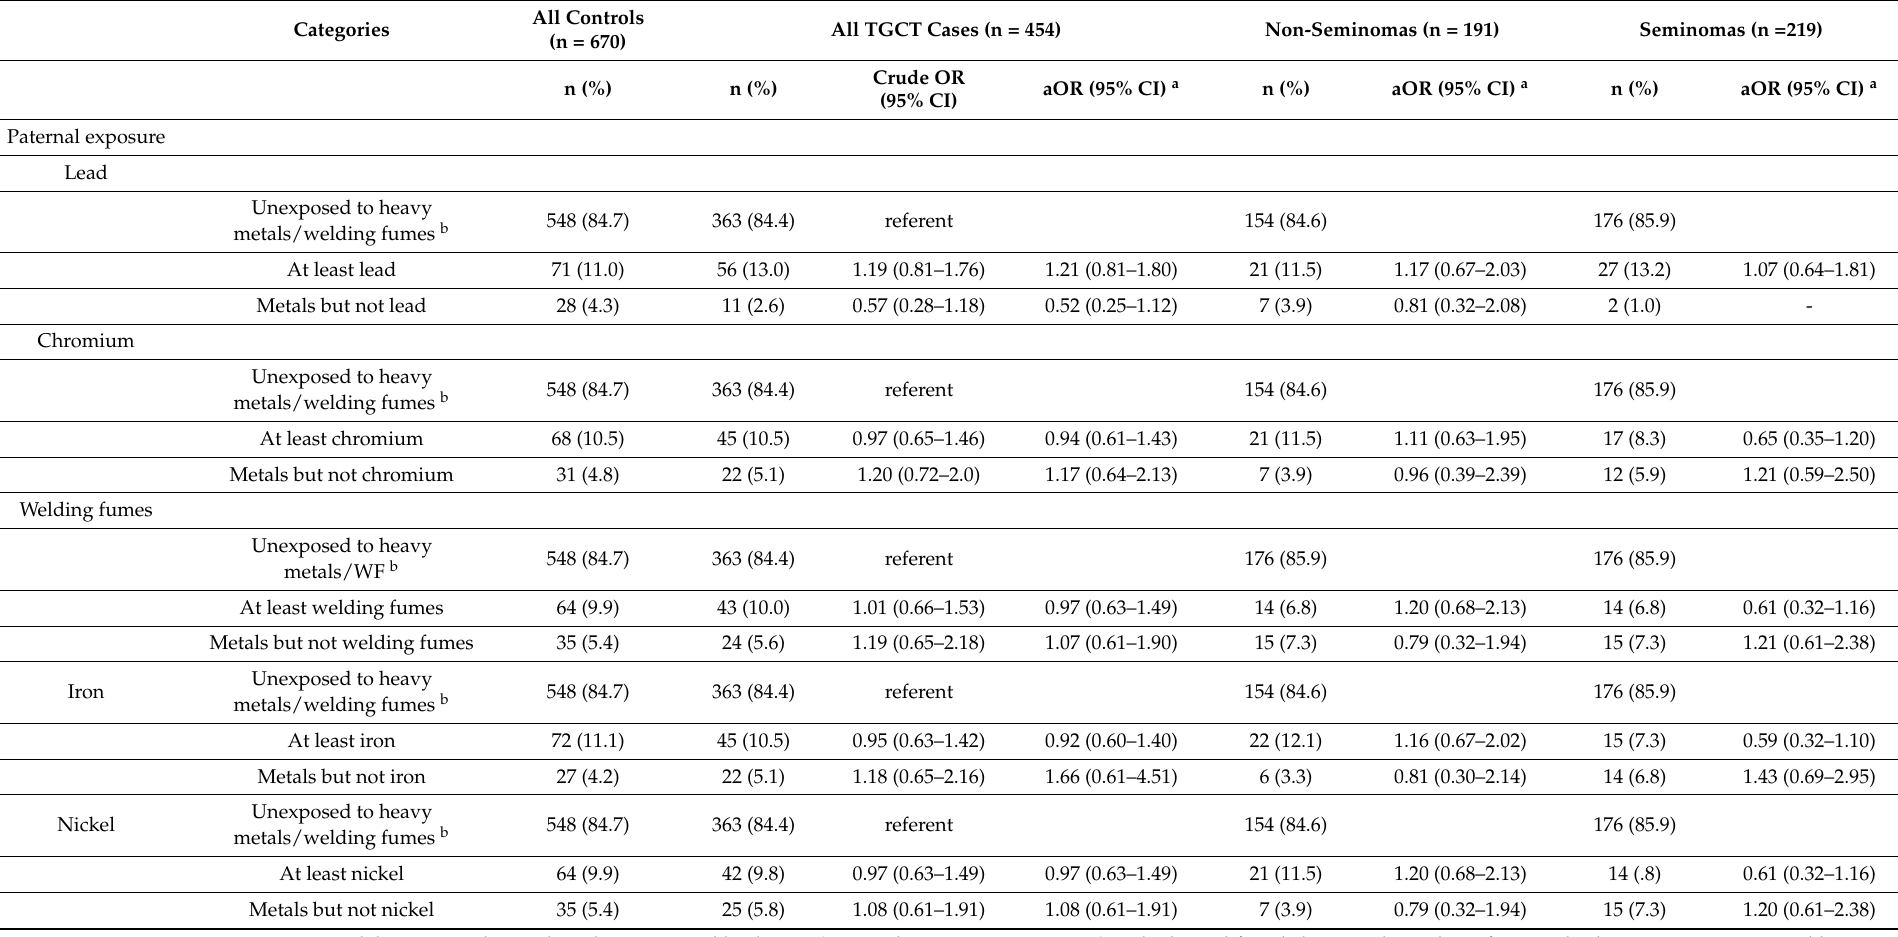
Table 3. Odds ratios (ORs) and 95% confidence intervals (95% CIs) of TGCT associated with paternal occupational exposure to metals using unexposed to any heavy metal as reference category (3 categories), TESTIS study, 2015–2018, France (N =